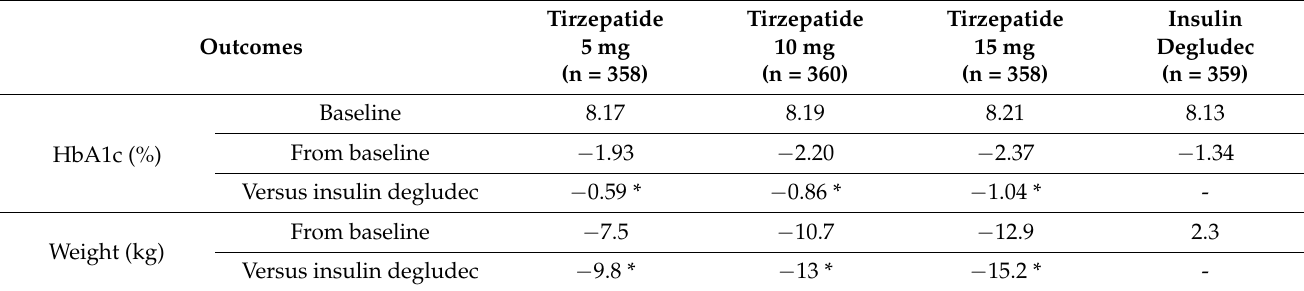
Table 3. Results of the SURPASS-3 trial at 52 weeks [44]. Efficacy analyses were performed in the mITT population; * p <